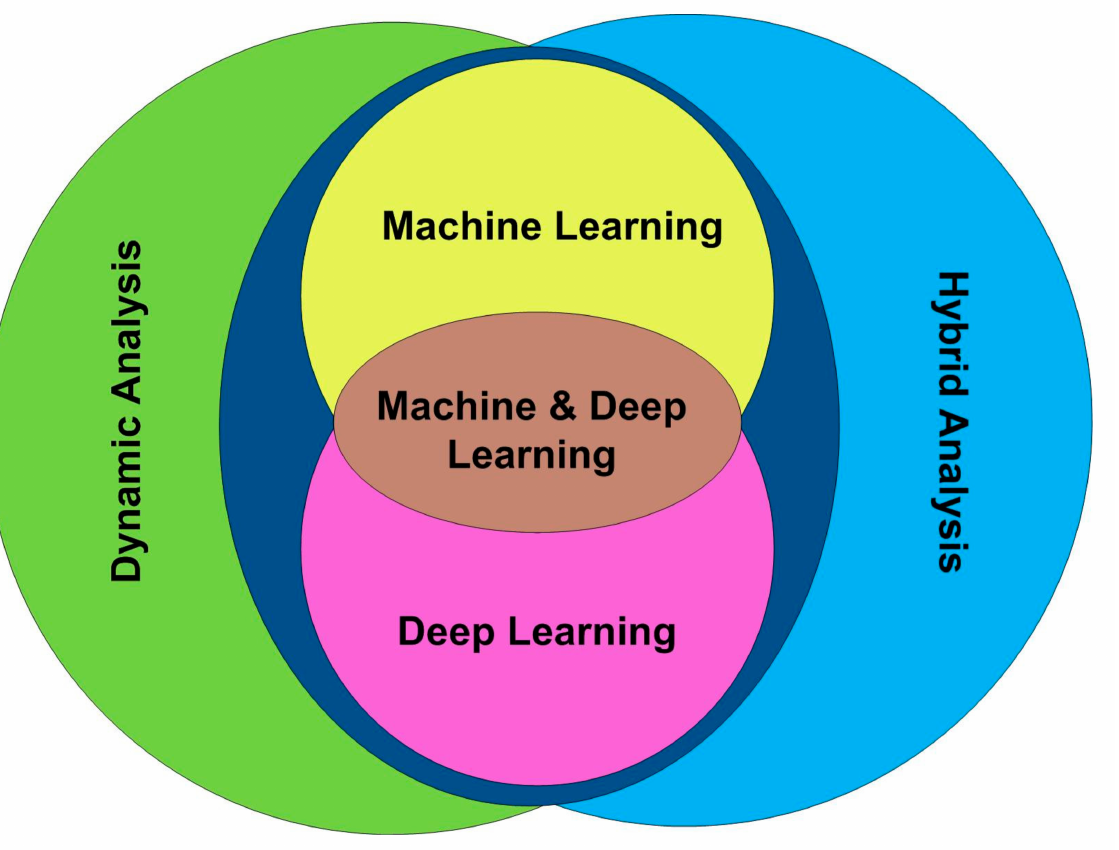
Figure 5. Ransomware analysis